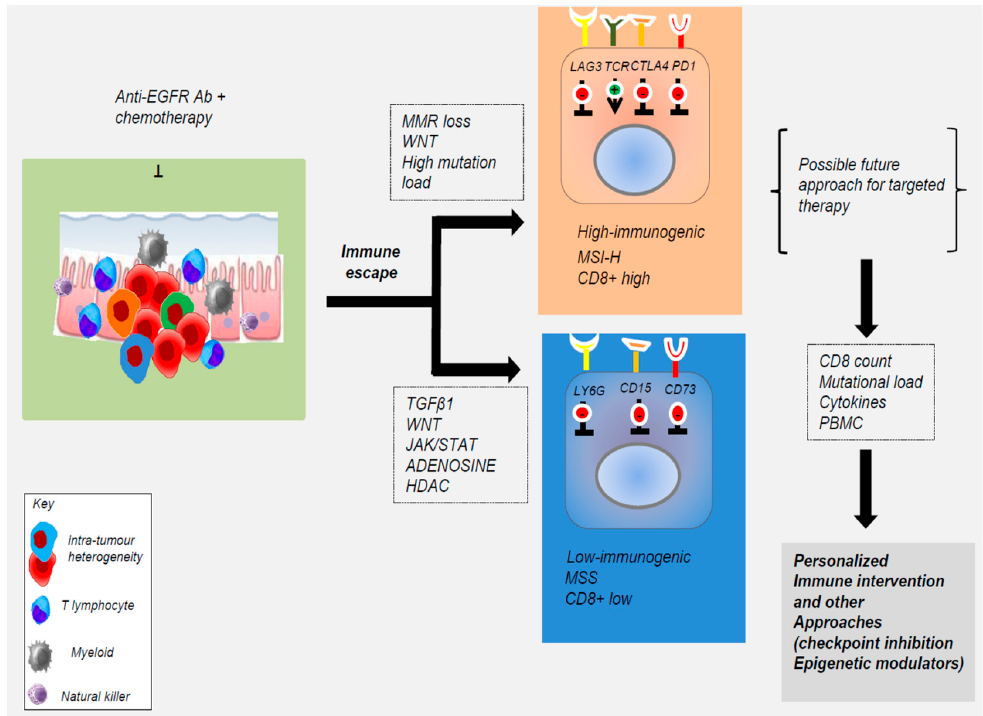
Figure 2. Tumor microenvironment (TME) is a key determinant for the response to anti-EGFR therapy. Tumors are complex adaptive systems owing to the heterogeneous nature of cancer cells and surrounding immune cell populations (T lymphocytes, myeloid cells, natural killer). In the clonal evolution model, from a founder cell, different subclones (represented by different colors) emerge due to genetic and epigenetic alterations resulting in the intratumor heterogeneity. EGFR and its ligands are differentially expressed in the tumor and surrounding immune cell populations. This heterogeneity can significantly affect the effectiveness of targeted therapies. Currently, immunotherapy (Anti-PD1) is restricted to a CRC subgroup harboring loss of mismatch-repair (MMR) proteins. Other CRCs do not meaningfully respond to any traditional immunotherapy approach, including checkpoint blockade, adoptive cell transfer, and vaccination. In the future, pathways and molecules determining the immunological profiling of tumor subtypes might be targeted together with anti-EGFR for therapeutic immune interventions. Abbreviations: microsatellite instable high (MSI-H); JAK , Janus kinase; Histone deacetylases (HDAC).